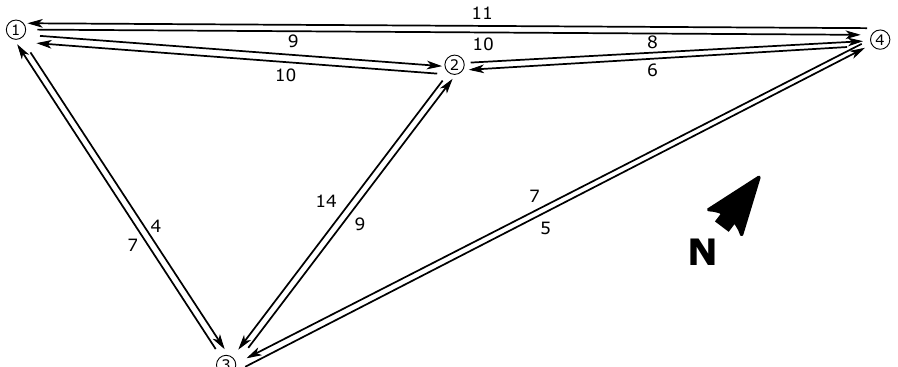
Figure 1. Graph indicating the time in minutes it takes to go from one place to another in Santiago de Compostela by car (using the least time consuming path) according to Google Maps —good traffic conditions assumed. The points are placed in their actual relative geometric positions, being 1 : Faculty of Mathematics (USC), 2 : Cathedral, 3 : Train station, 4 : Bus station. Most of the streets in Santiago are one way, which accounts for the differences in time depending on the direction of the